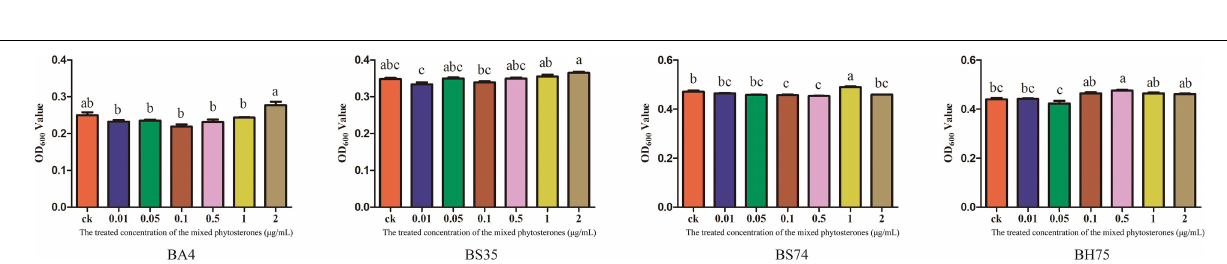
FIGURE 6 | The effects of a mixture of phytosterone on the growth of beneficial bacteria [including Bacillus amyloliquefaciens 4 (BA4), Bacillus subtilis 35 (BS35), Bacillus subtilis 74 (BS74), and Bacillus halodurans 75 (BH75)]. Small letters in figures show significant differences determined by Tukey’s test ( p ≤ 0.05, n = 3).